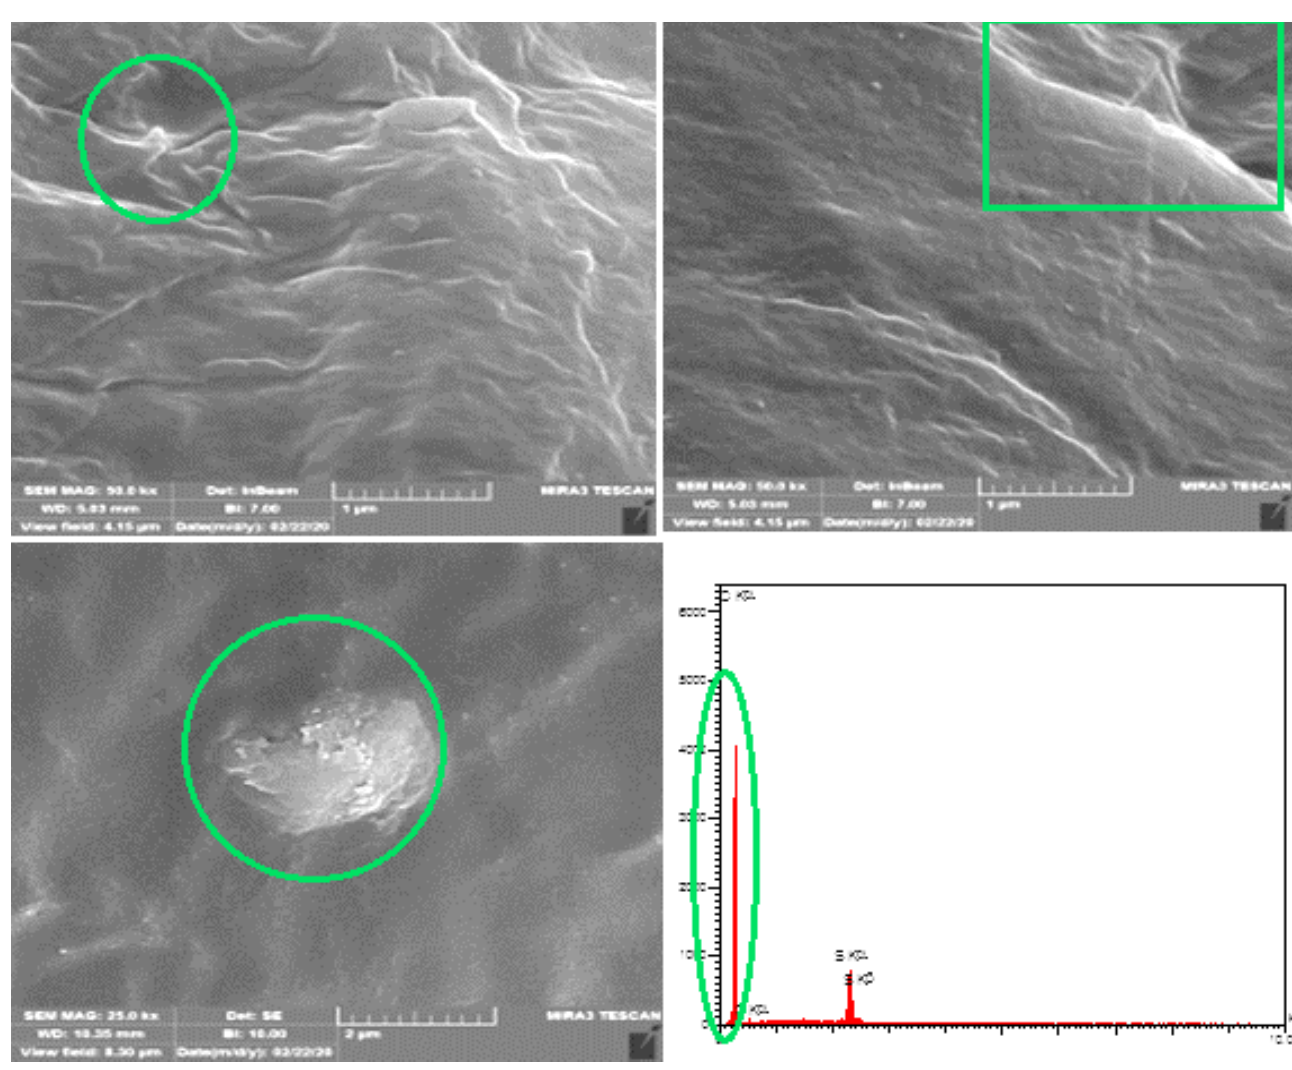
Figure 6. FE-SEM and EDX for asphalt (as received).